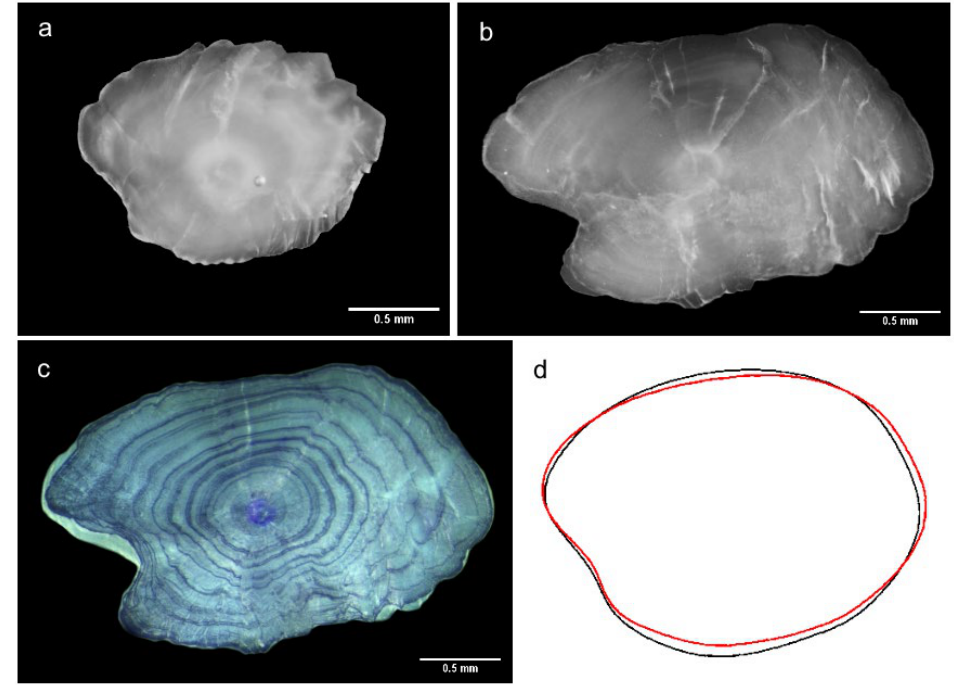
Figure 2. Right sagittal otoliths: in the first image ( a ), the otolith rings are visible with the clearing agent, followed by a non-readable ground otolith ( b ) and the resulting rings’ visualization after coloration ( c ). The last image ( d ) is the averaged outline contour of the Elliptic Fourier analysis, in red for the estuary and black for the tributaries.